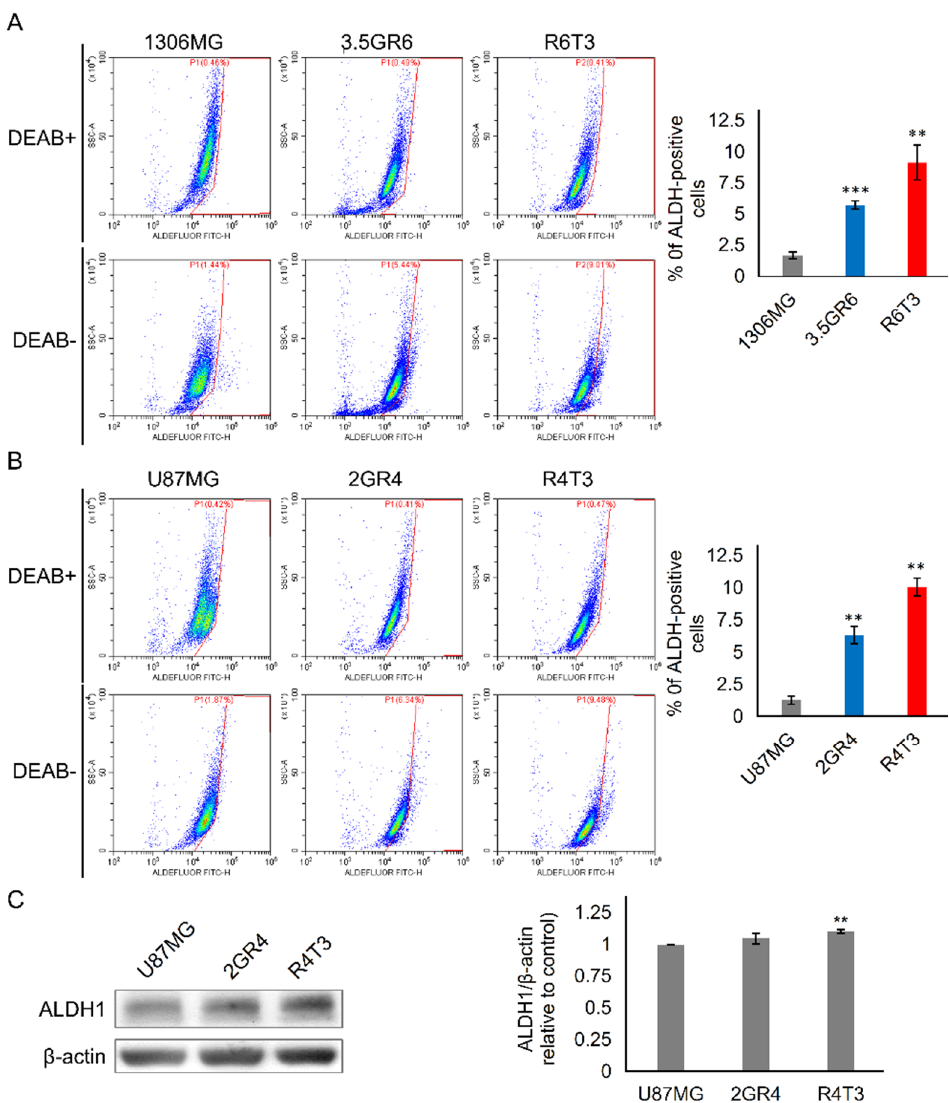
Figure 3. Developing therapeutic resistance-activated aldehyde dehygrogenases. The activity of aldehyde dehygrogenases (ALDHs) was measured using the ALDEFLUOR assay with flow cy- tometry. N, N-diethylaminobenzaldehyde (DEAB) was used to inhibit ALDH. ( A ) Representative flow cytometry plots and histograms showing the activity of ALDHs in 1306MG, radiation-resistant 3.5GR6, and radiation-TMZ-resistant R6T3; N = 3 for 3.5GR6; N = 4 for 1306MG; N = 5 for R6T3; ( B ) representative flow cytometry plots and histograms showing the activity of ALDHs in U87MG, ra- diation-resistant 2GR4, and radiation-TMZ-resistant R4T3; N = 3; ( C ) WB and histogram showing the protein expression of ALDH1A1 of U87MG, radiation-resistant 2GR4, and radiation-TMZ- resistant R4T3; N = 3; mean ± SEM; * indicates comparison with parental 1306MG or U87MG; **, p < 0.01; ***, p <